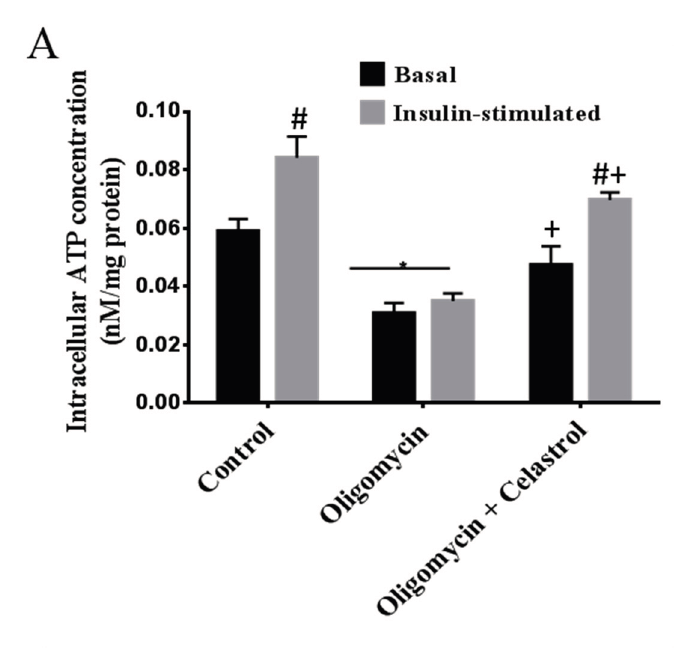
Figure 2. Effects of celastrol on mitochondrial function of differentiated 3T3-L1 adipocytes with mitochondrial dysfunction was assessed via ( A ) intracellular ATP concentration; ( B ) mitochondrial membrane potential (MMP) and ( C ) mitochondrial superoxide